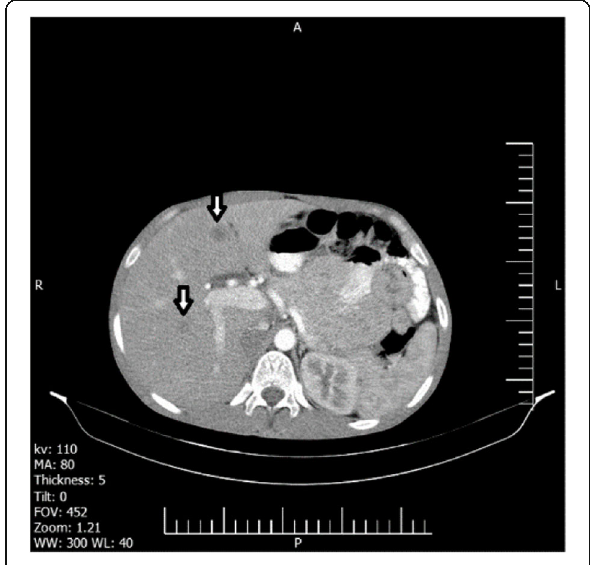
Fig. 4 Triple-contrast CT scan of the abdomen. Low attenuated lesions are seen in the liver (arrows)